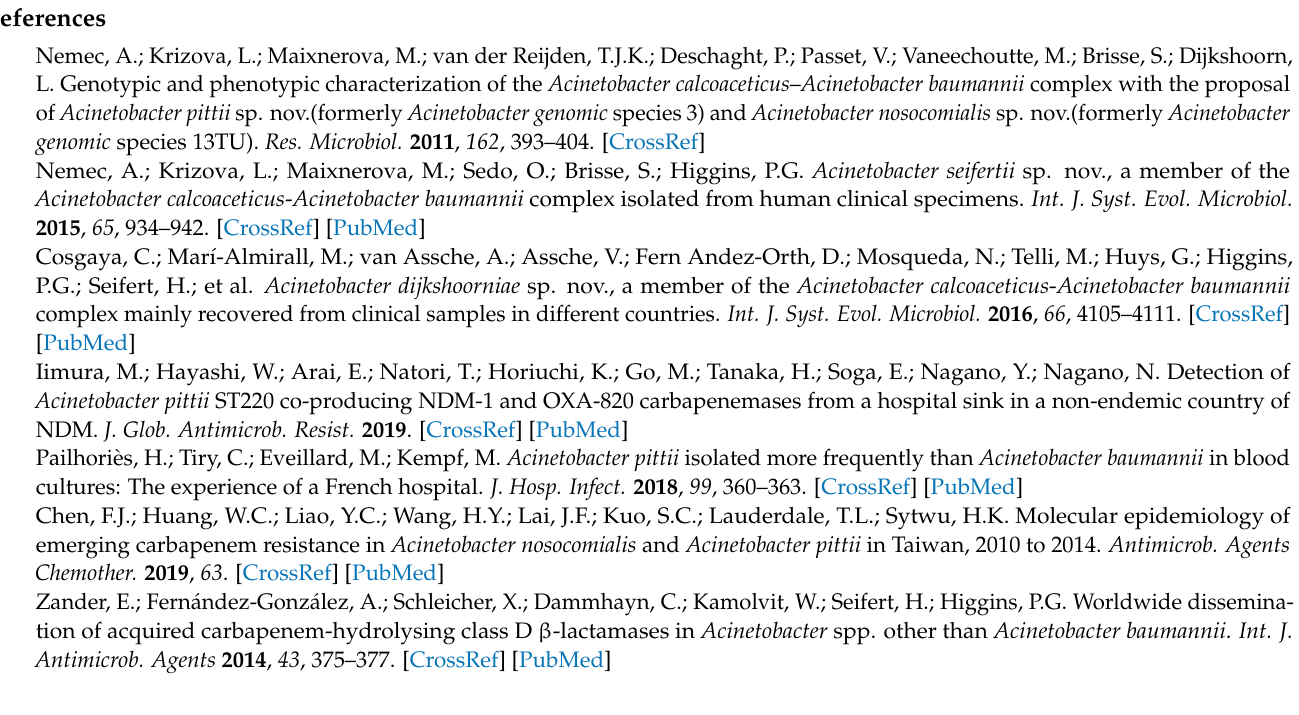
A. pittii ., Table S1: Primers sequences for detection Acinetobacter species and carbapenem resistant genes, Table S2: Primers sequences for detection of plasmid typing, Table S3: Genome information of carbapenem resistance Acinetobacter pittii